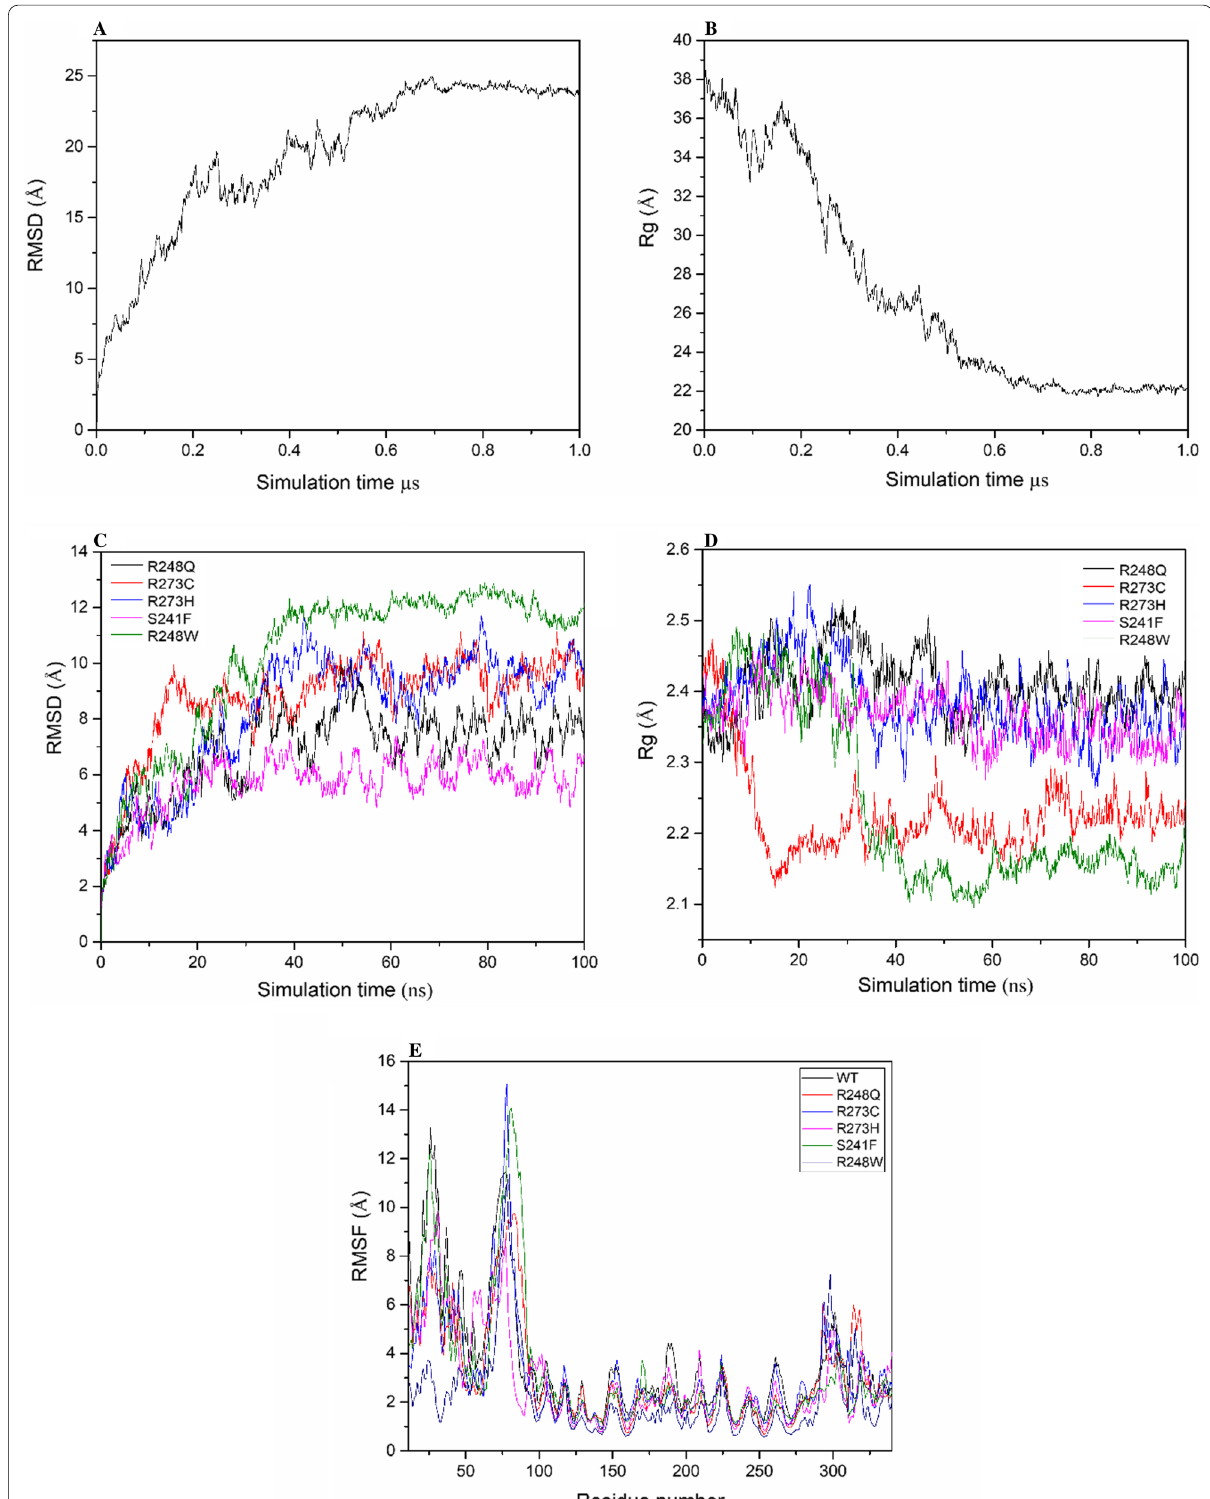
Fig. 3 RMSD, Rg, and RMSF analysis of the wild-type and mutant p53 protein. RMSD ( A ) and Rg ( B ) analysis of wild-type p53. RMSD ( C ), Rg ( D ), and RMSF ( E ) analysis of the wild type and mutants of p53